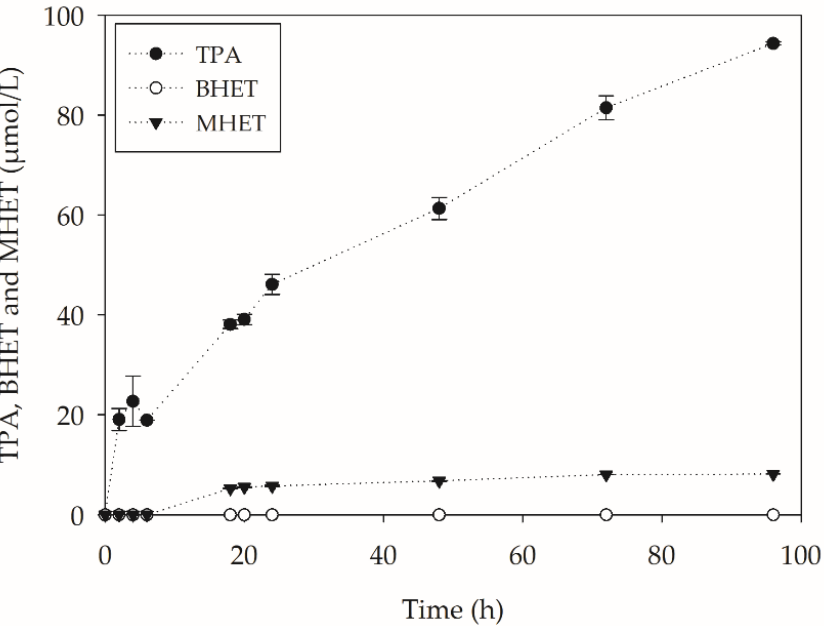
Figure 11. PET hydrolysis products obtained during Y. lipolytica cultivation in bioreactors (450 rpm, 1 vvm and 28 °C) containing YT medium + PC-PET (500 mg/L) for 96 h.